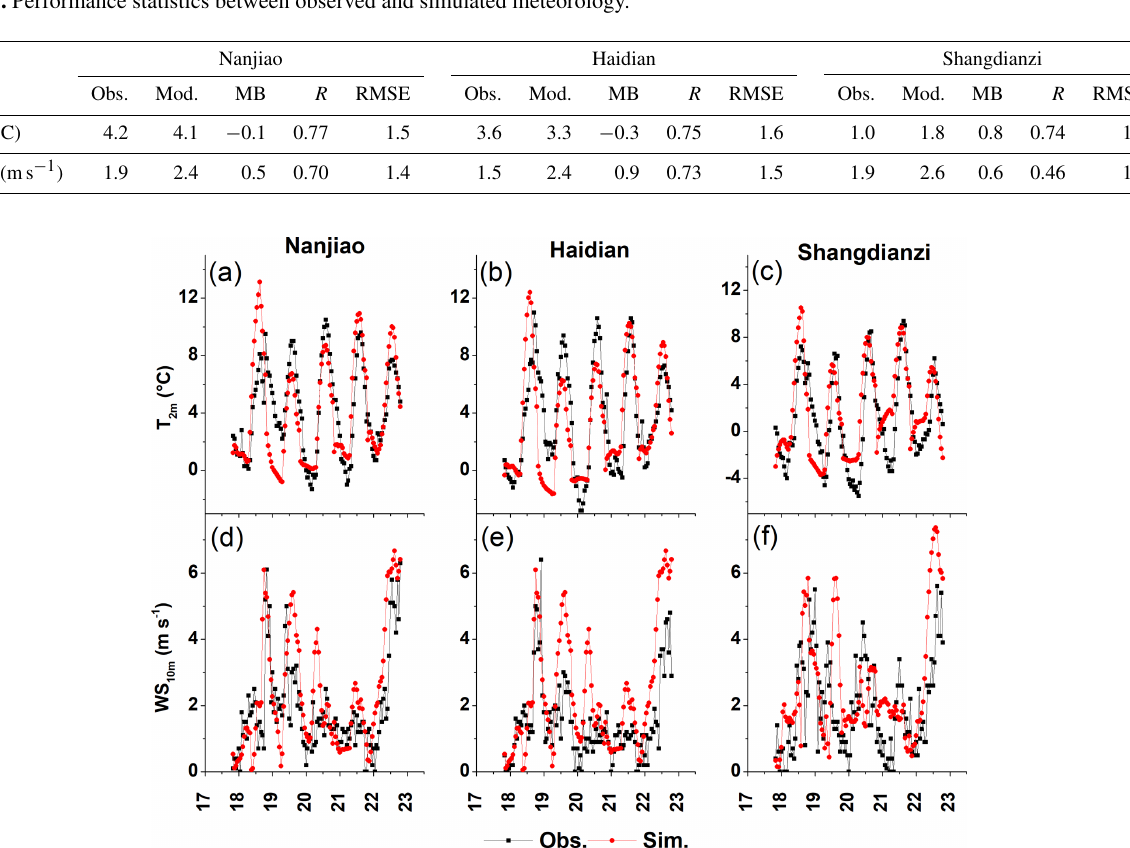
Figure 7. The temporal variations of observed and simulated hourly 2m temperature (T2m) (a–c) and 10m wind speed (WS10m) (d–f) at Nanjiao, Haidian, and Shangdianzi stations. The observed WS10m are 10min averaged wind speed for 17–23 November